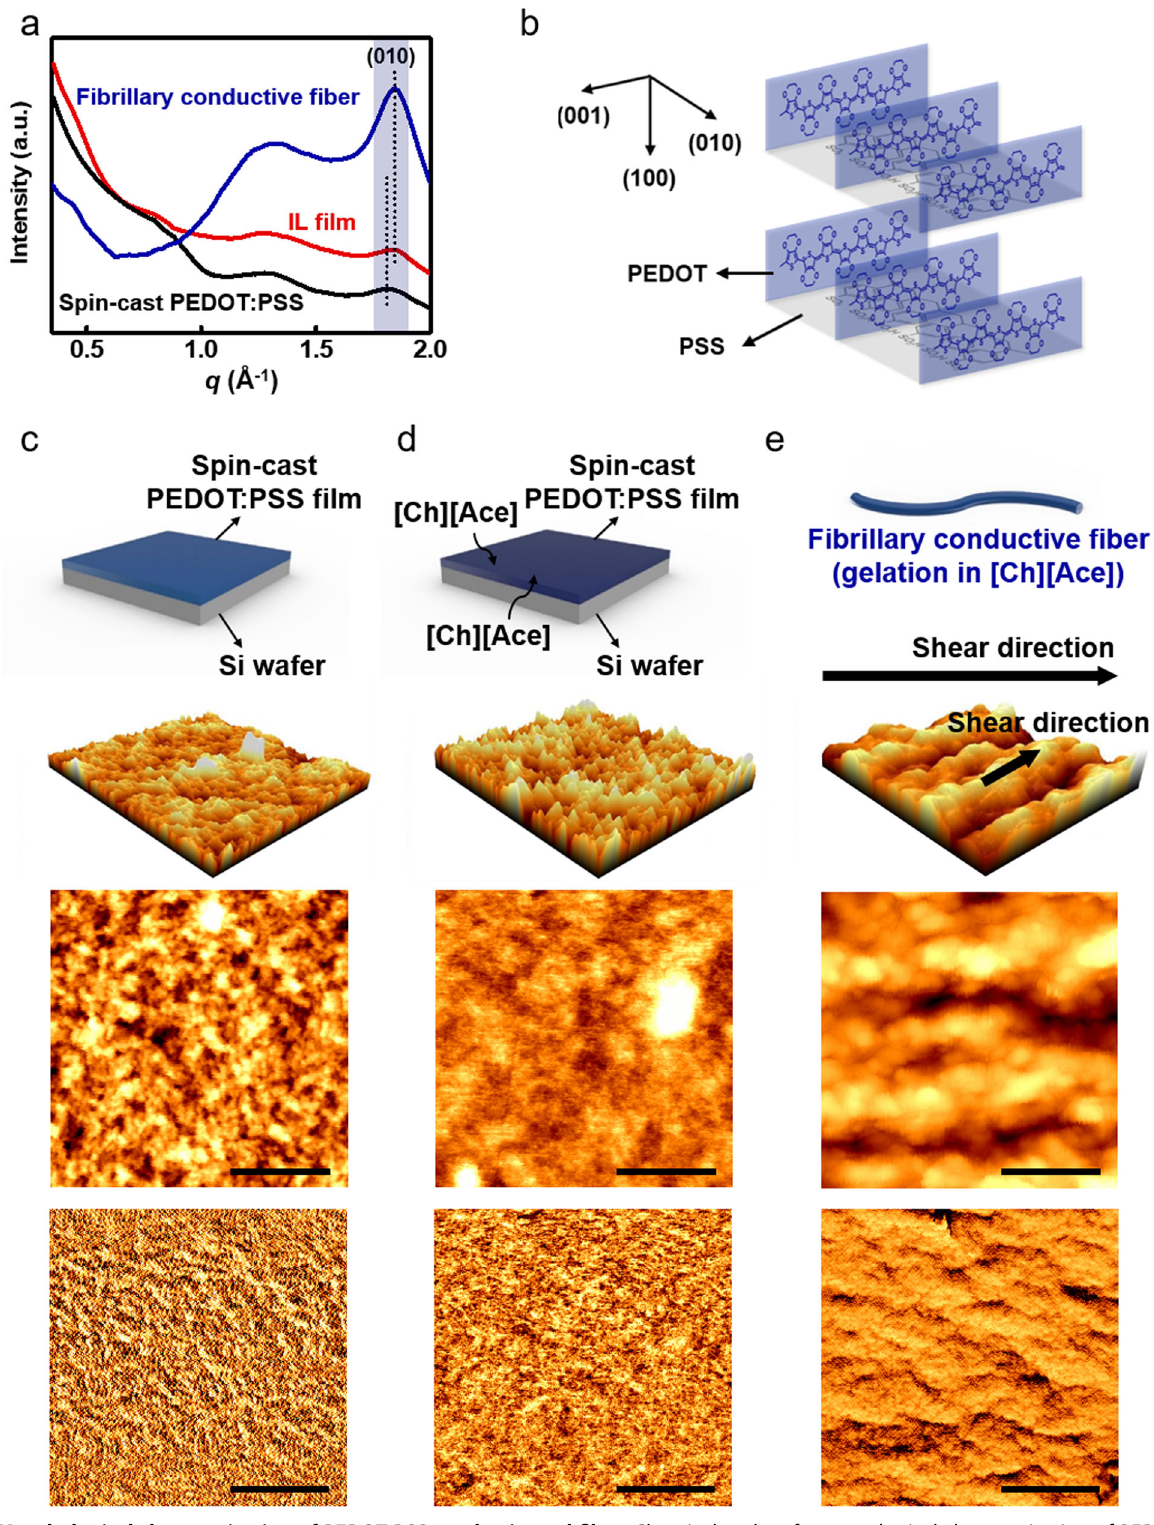
Fig. 2 Morphological characterization of PEDOT:PSS conductive gel fi ber. Chemical and surface topological characterization of PEDOT:PSS conductive gel fi ber. a XRD (TR-WAXD) spectra for spin-cast pristine PEDOT:PSS fi lm (black), PEDOT:PSS fi lm swelled in IL (Red) and fi brillary conductive gel fi ber (blue). b Schematic diagram for molecular packing structure of semi-crystalline PEDOT:PSS. (010) direction means π - π stacking of PEDOT. Surface topologies (Top and middle) and phase (bottom) of PEDOT:PSS by AFM measurement. Spin-cast PEDOT:PSS fi lm for c , spin-cast PEDOT:PSS fi lm swelled in choline acetate for d , and PEDOT:PSS conductive gel fi ber by fi brillary gelation with choline acetate for e . (all scale bars show 0.5 μ